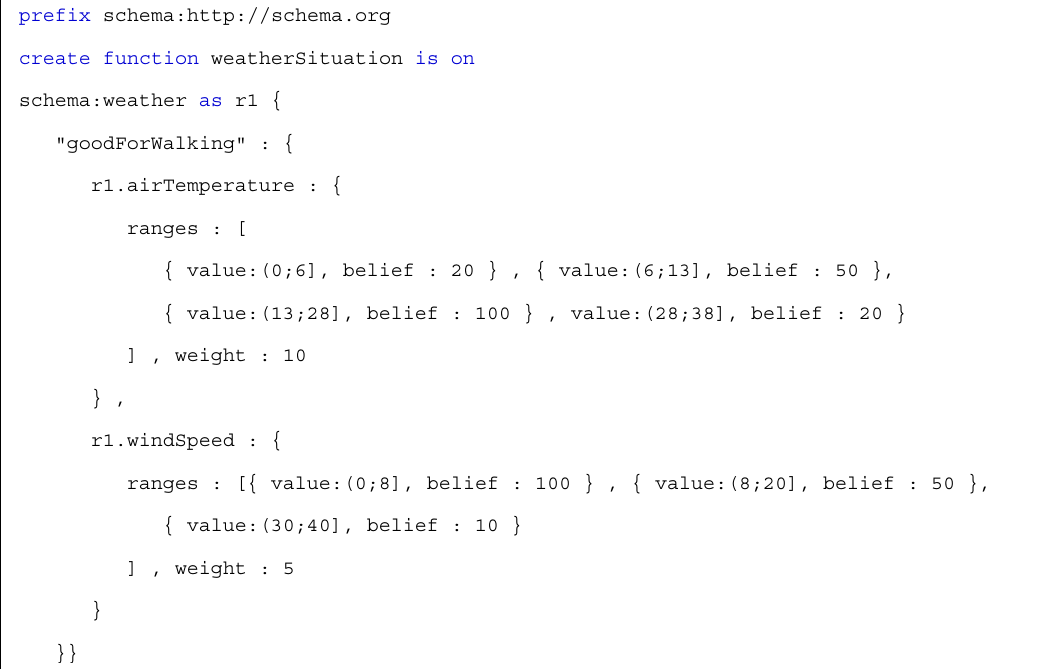
Scheme 12. Example of example of CST-based situation function definition.